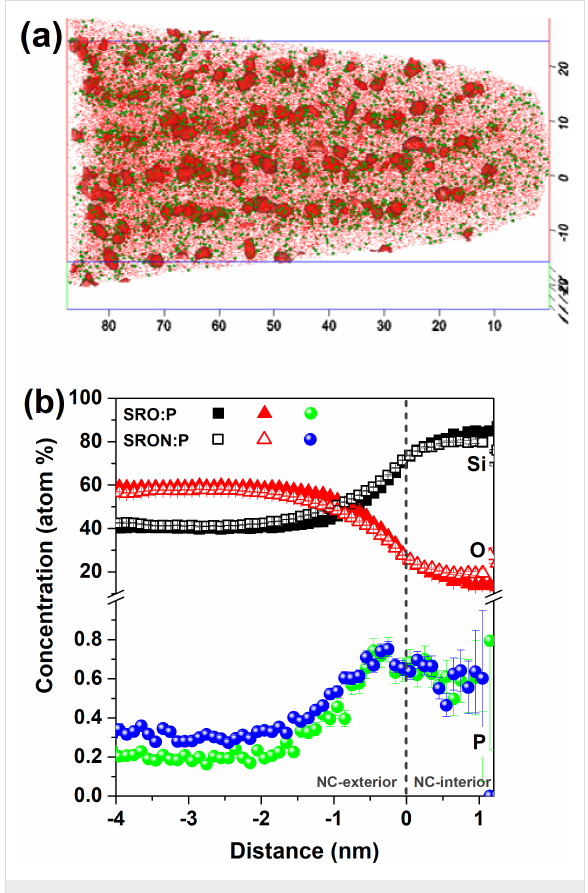
Figure 2: (a) Atom probe tomography reconstruction of P-doped Si nanocrystals (red iso-surfaces with ≥ 70 atom % Si) in N-free SiO 2 matrix (P-atoms: green; Si-atoms: red; all axes in nm). (b) Proxigram analysis of Si NCs grown from SRO:P (0.59 atom %) and SRON:P (0.71 atom %). The local P-concentrations are depicted in green for SRO:P and blue for SRON:P. Positive distances refer to the inner NC-volume, negative distances to the surrounding